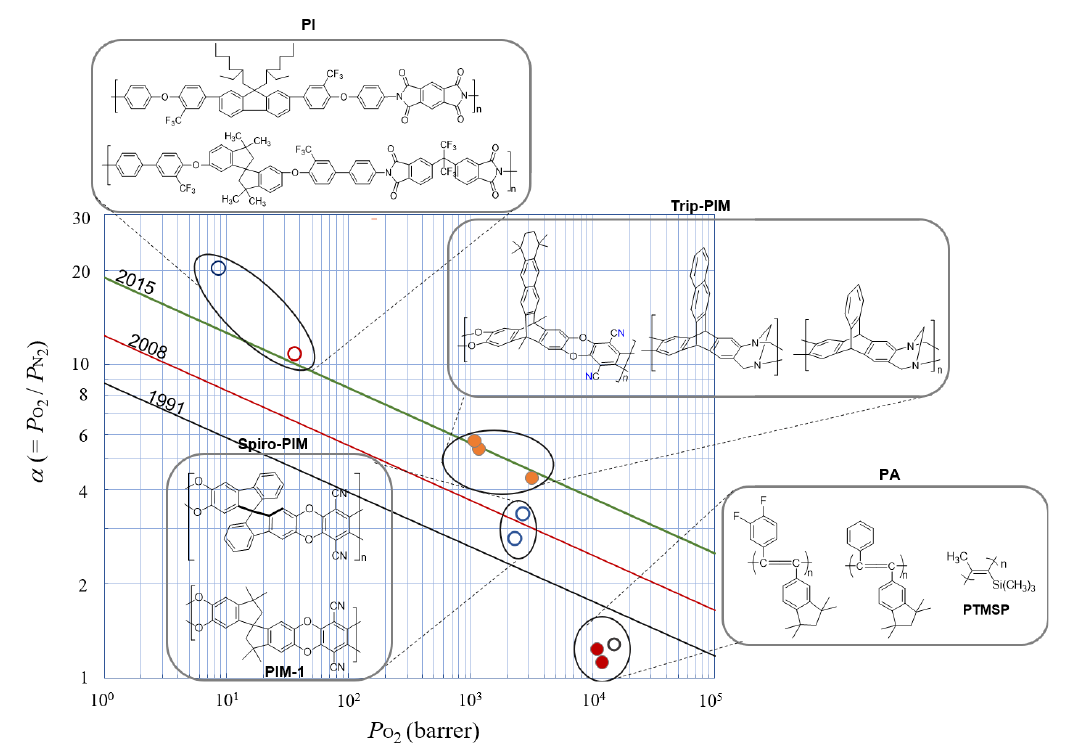
Figure 2. Robeson’s 1991, 2008, and Pinnau’s 2015 upper bound lines for oxygen/nitrogen permeation through polymer membranes with plots for milestone polymers ( ● : after aging, ○ : before aging).